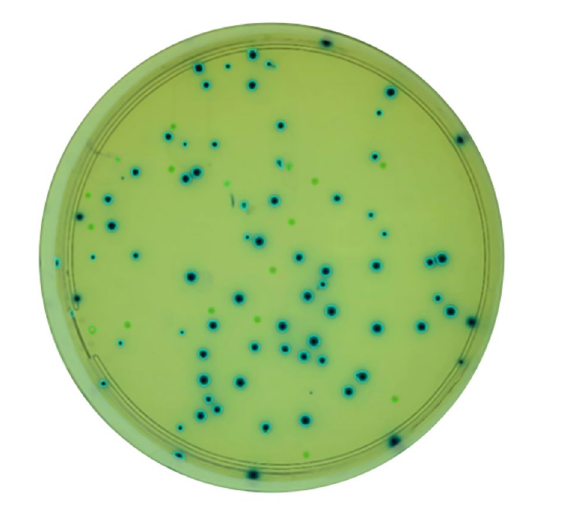
Fig. 6 Segmented plate containing blue and white E. coli colonies. White colonies are circled in green and blue colonies are circled in